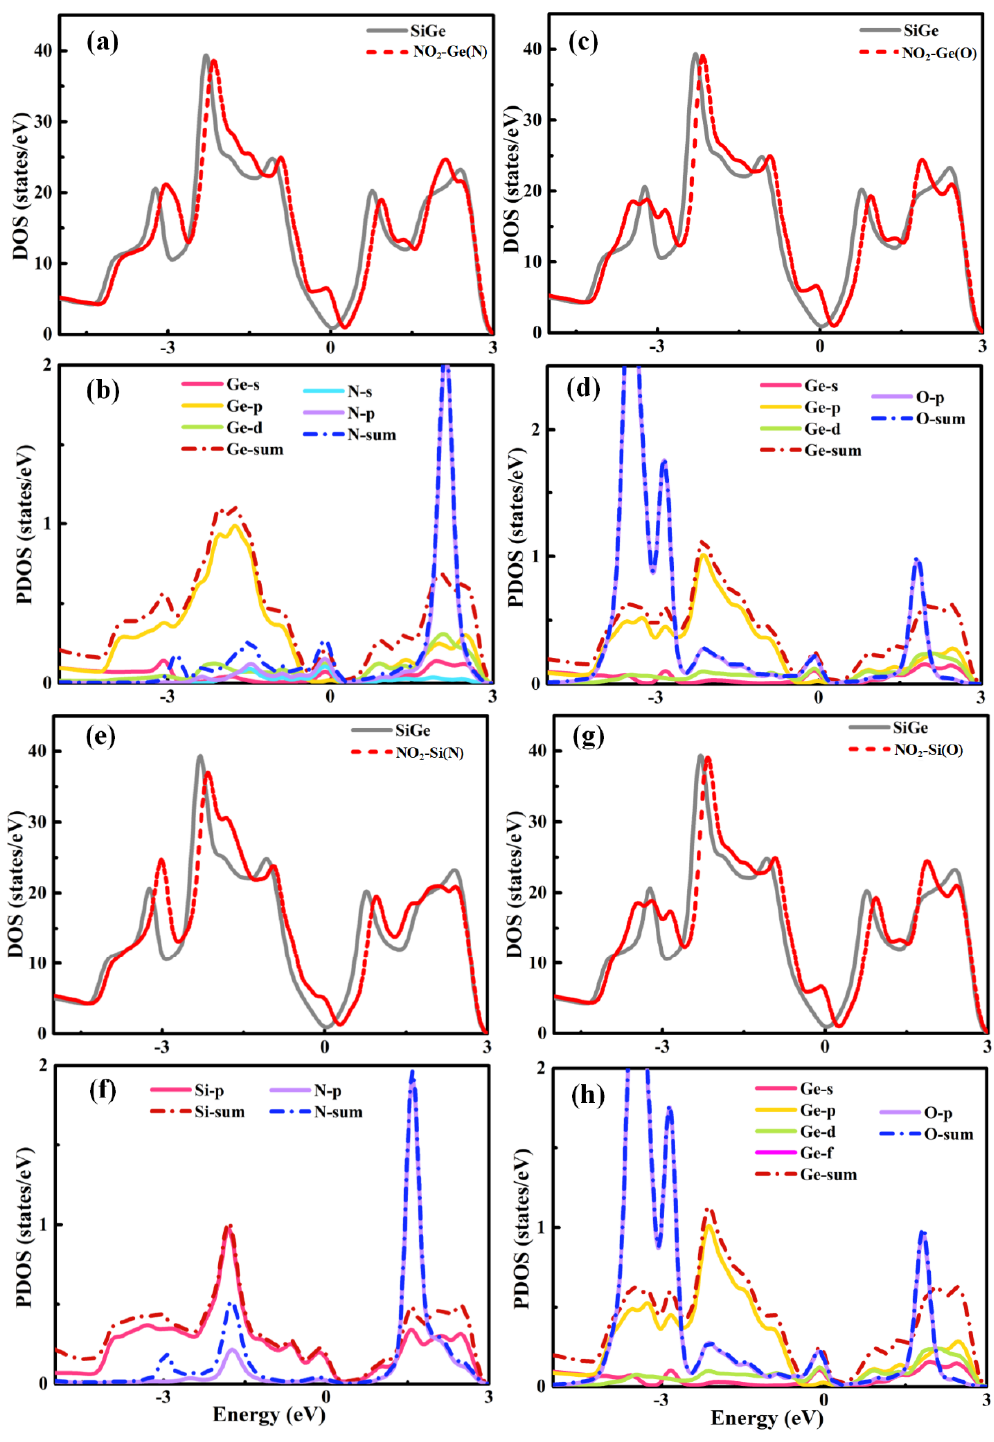
Figure 5. Total/partial density of states for ( a ),( b ) NO 2 -Ge(N), ( c ), ( d ) NO 2 -Ge(O), ( e ), ( f ) NO 2 -Si(N), and ( g ), ( h ) NO 2 -Si(O) adsorptions (Figure a,c,e and g are total density of states; Figure b,d,f and h are partial density of states).